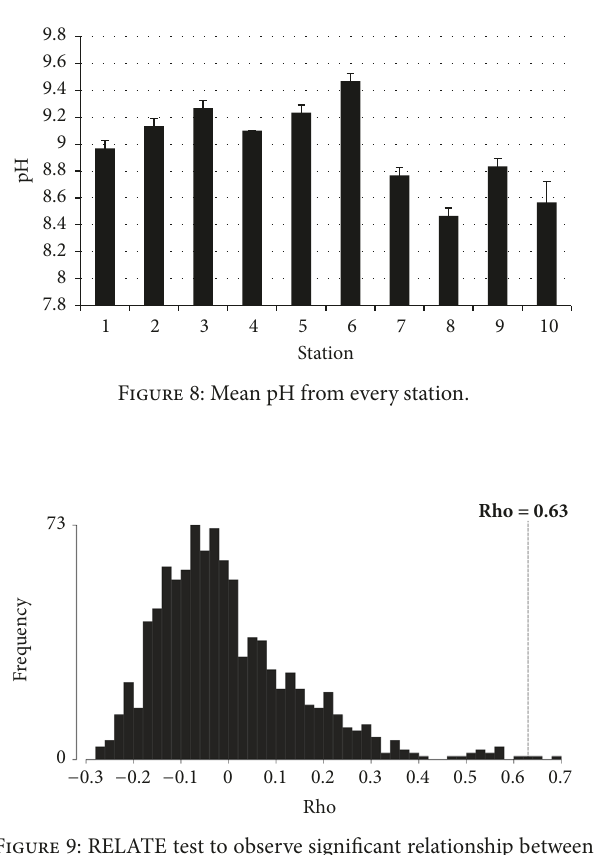
Figure 9: RELATE test to observe significant relationship between Holothuria leucospilota community and environmental data. The histograms are the null permutation distributions of possible val- ues for the RELATE match (Spearman 𝜌 s), in the absence of a biota-environment relationship. The observed 𝜌 s = 0.63 which is indicated by the dotted line on the right showed presence of the biota-environment relationship as the line is located outside the